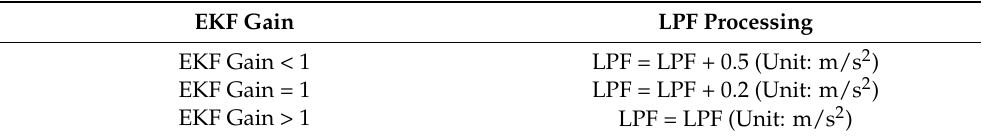
Table 2. Design logic of upper-limit modulation of low-pass filter before